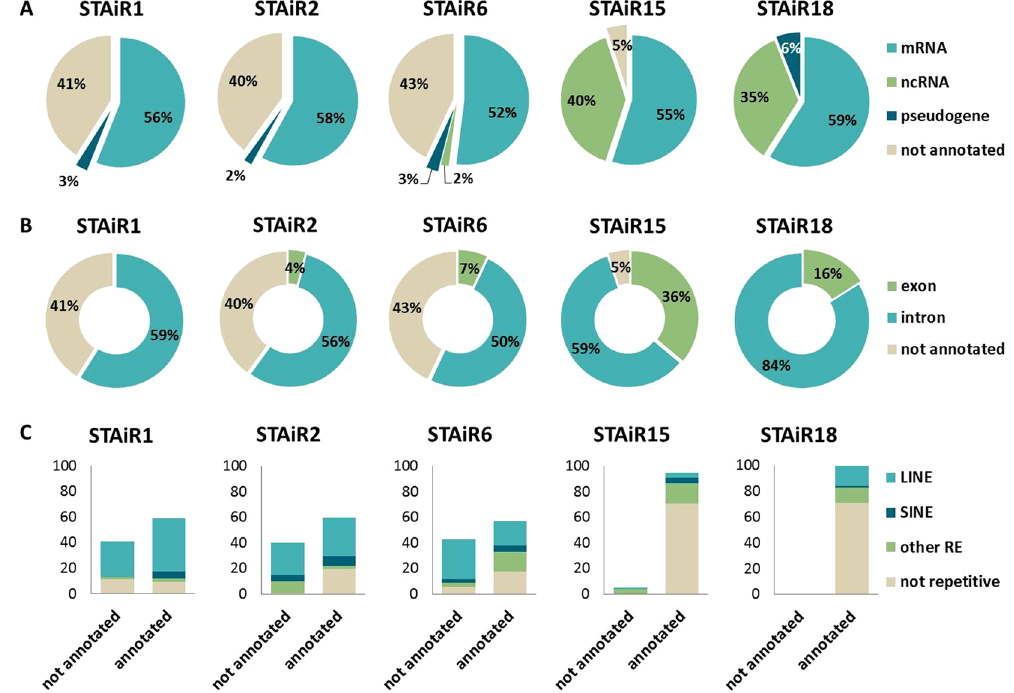
Figure 4. Identification of STAiR RNA-binding partners. ChIRP-RNA-sequencing was performed using 12 biotinylated oligonucleotides per STAiR RNA target (STAiRs 1, 2, 6, 15, 18) and 6 oligos for bacterial lacZ as a negative control. The pulldown was performed within crosslinked and chromatin-fragmented cell lysates of 2 × 10 7 permanently IL-6 stimulated (10 ng/ml) INA-6 cells each. The RNA targets together with their RNA interaction partners were separated by streptavidin beads, following a total RNA preparation and DNase digestion. Library preparation (Scriptseq, Epicenter) and a subsequent NGS was performed for an RNA pool of five independent experiments. Identified reads were mapped to the human genome hg19. The reads belonging to the 100 most enriched genomic positions were analyzed for every STAiR pulldown compared to the lacZ negative control in order to identify ( A ) their origin within the human genome, ( B ) intragenic position, and ( C ) repetitive content and